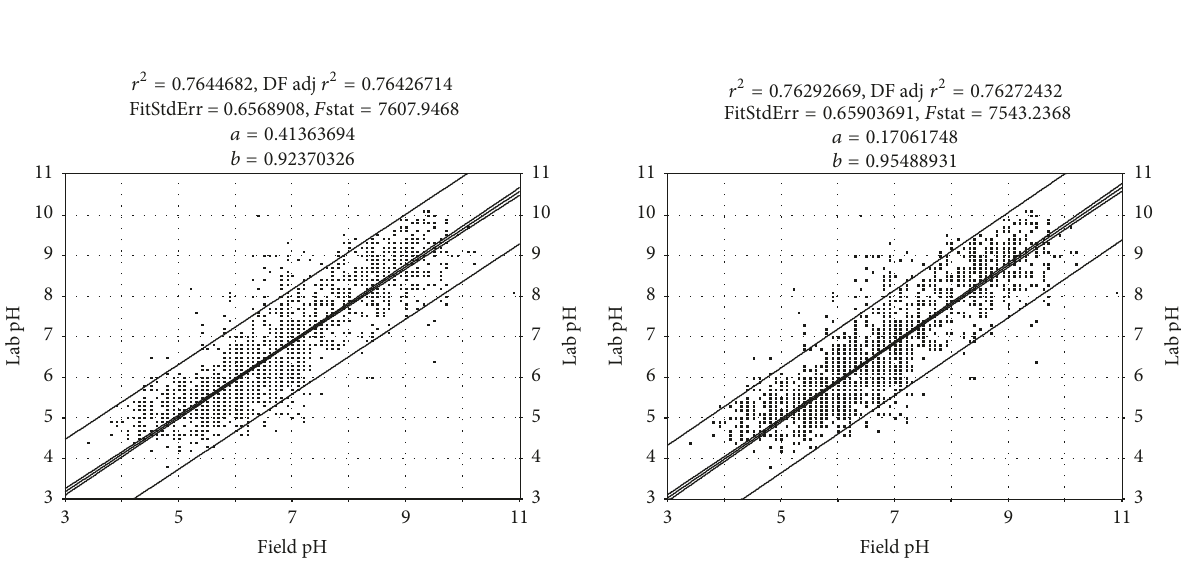
(a) Linear model (randomised data) for field pH F versus pH W with least- squaresminimisationand95 % CI(narrowband)and95 % PI(broadband)